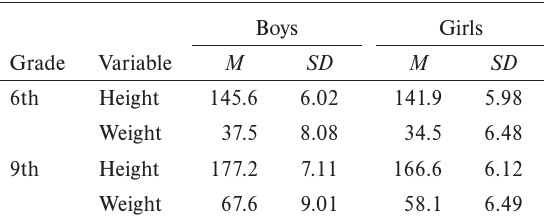
The mean and SD of body height and weight of boys and